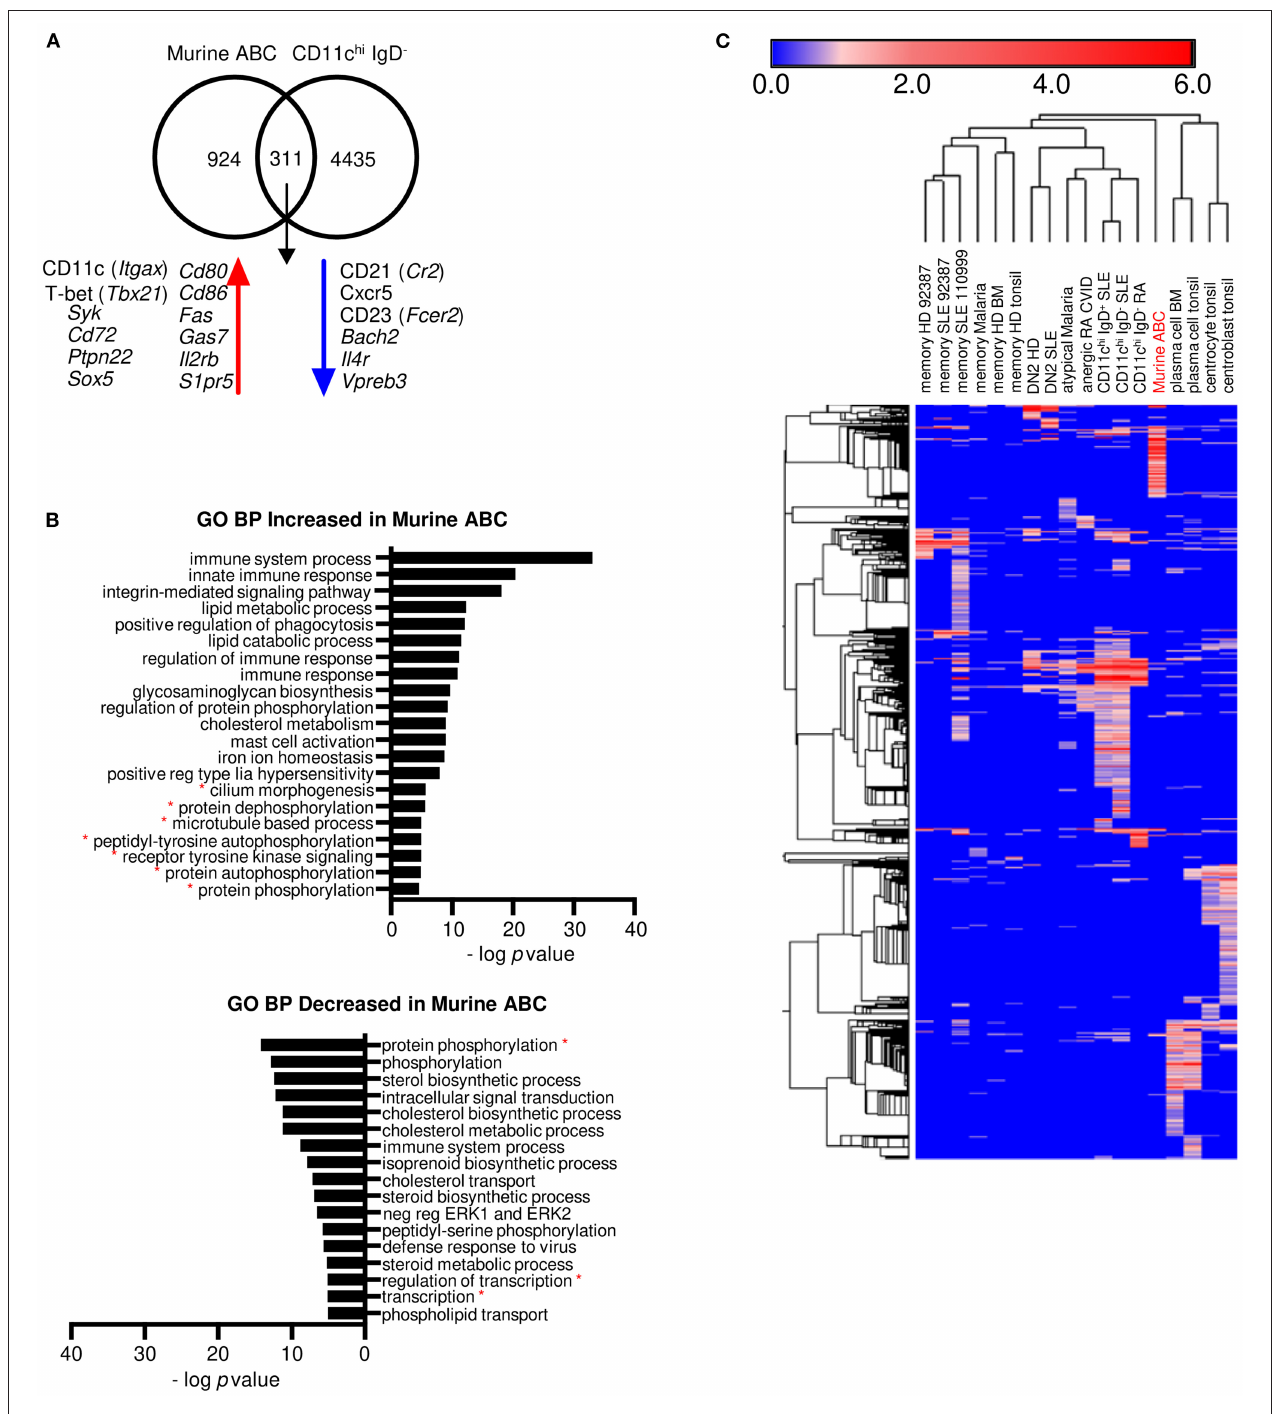
FIGURE 5 | Marker genes and a few pathways are similar between human CD11c hi IgD − B cells and mouse ABCs, but ABCs are mostly distinct from the human cells. (A) Transcripts in common and either increased or decreased between murine ABC DE to murine FO B cells (GSE28887) and human CD11c hi IgD − B cells DE to human naïve B cells (GSE110999). Murine gene symbols were translated to human orthologs and compared to human gene symbols (gene symbols in Supplementary Data File 10 ). (B) GO BP analysis of increased and decreased transcripts of murine ABC compared to murine FO B cells. Red asterisks indicate pathways in common with human CD11c hi B cells. Mouse gene symbols for increased or decreased genes were entered directly into DAVID for GO BP analysis and enriched categories with genes listed are in Supplementary Data File 11 . (C) Hierarchical clustering of the log fold change for increased genes from each human cell type DE to naïve human B cells, and murine ABC cells DE to murine FO B cells. Murine genes were converted to human orthologs for this analysis. The color numerical scale represents the log fold change to naïve B cells. Morpheus (https://software.broadinstitute.org/) was used for hierarchical clustering. Gene symbols and LFC are listed in Supplementary Data File 12